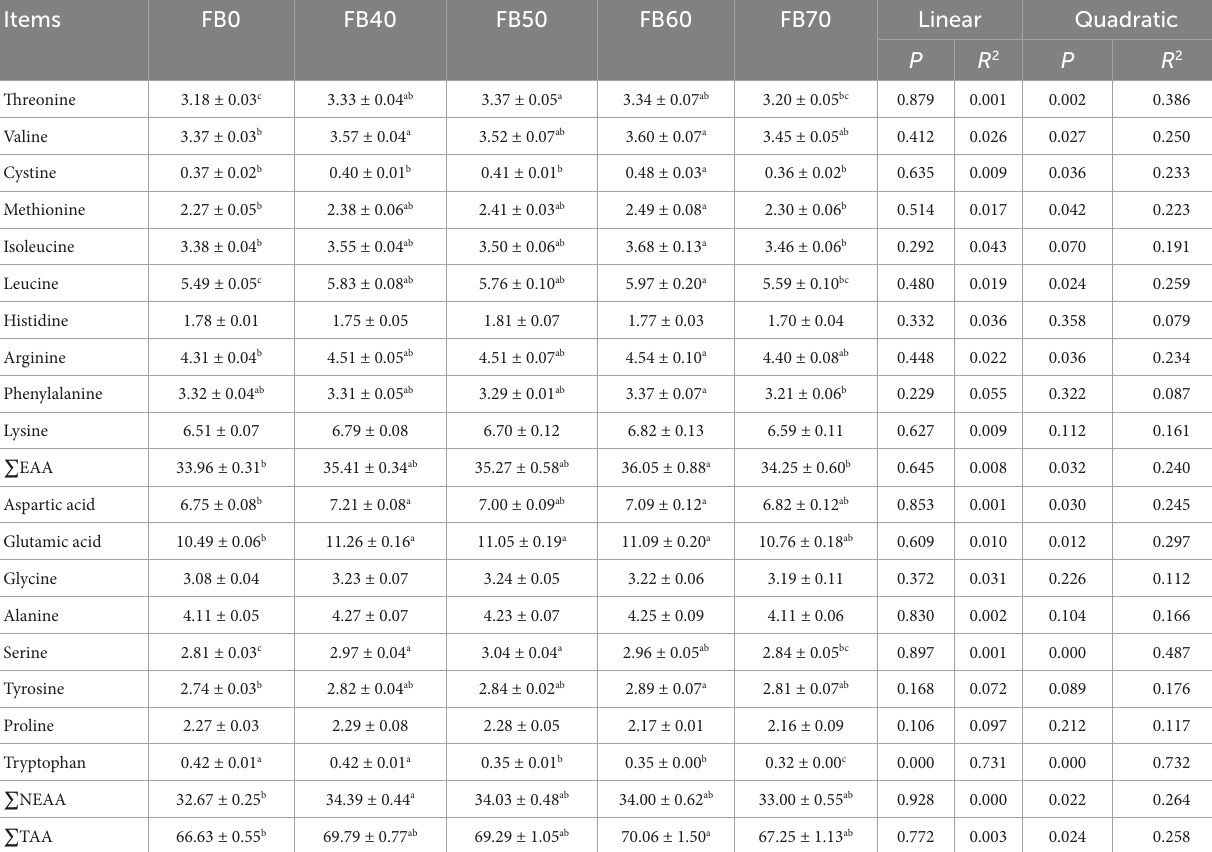
TABLE 4 Effects of dietary faba bean levels on amino acid composition (g/100 g dry weight) in muscle of tilapia Oreochromis niloticus.